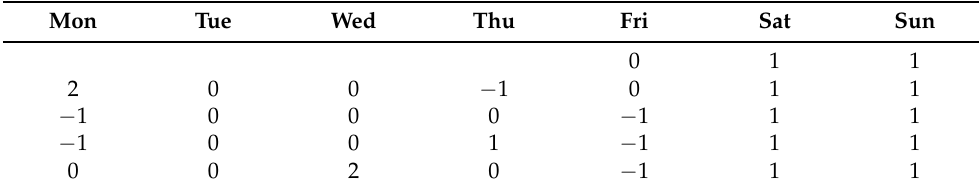
Table 3. Clustering results of KPI time series data